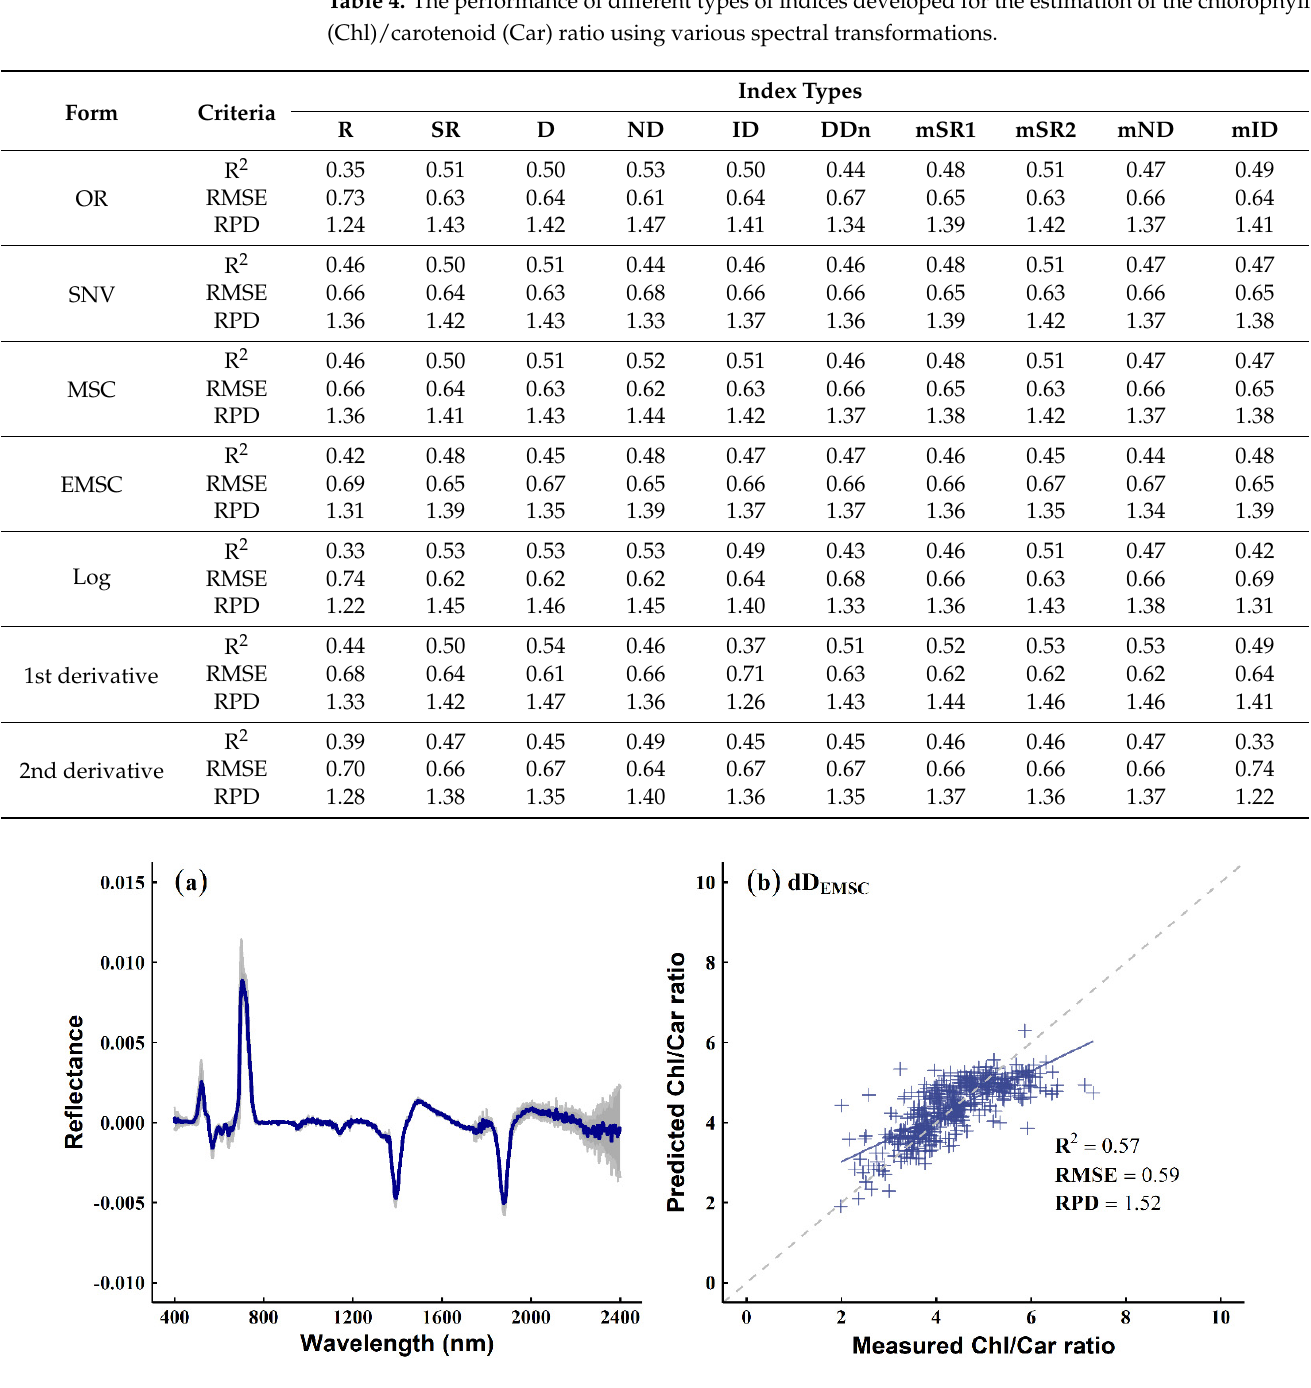
Figure 3. The reflectance resulting from the pre-processing of both extended multiplicative scatter correction (EMSC) and first-order derivative (1st derivative) ( a ) and the performance of the devel- oped best index for assessing the Chl/Car ratio ( b ).